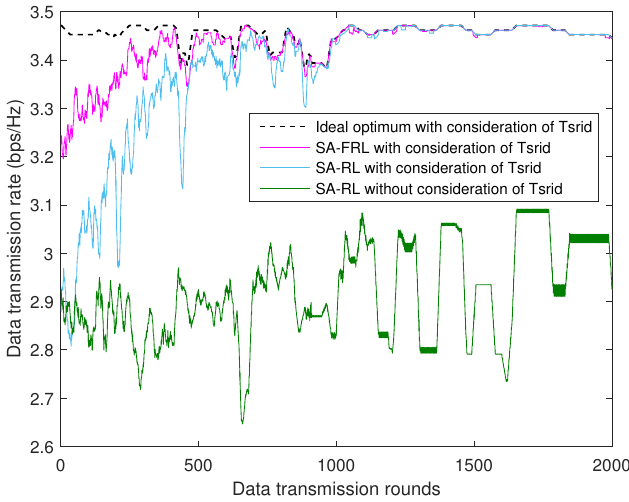
Figure 11. Data transmission